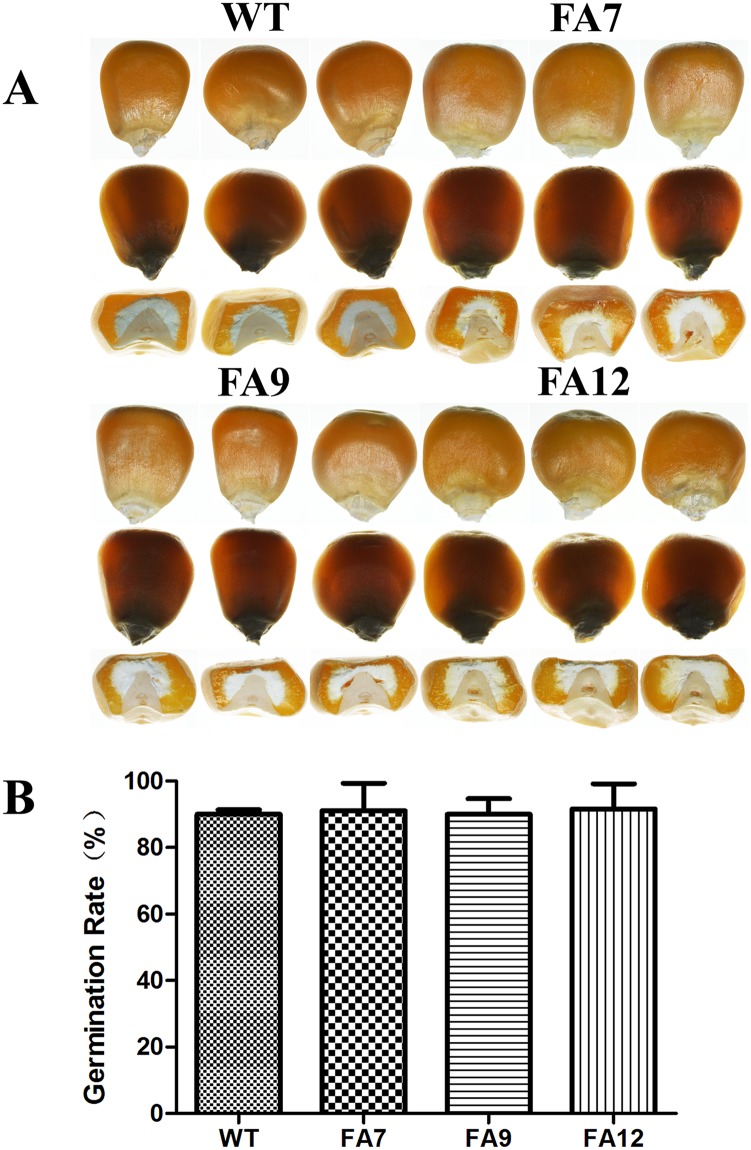
Kernel phenotype of T6 seeds in WT, FA7, FA9 and FA12.(A) Photographs of kernels were taken with incandescent light (Top and Bottom) and transmitted light (Middle). (B) Germination rate of T6 seeds. Student’s t-test was used to evaluate differences between each transgenic line and WT.